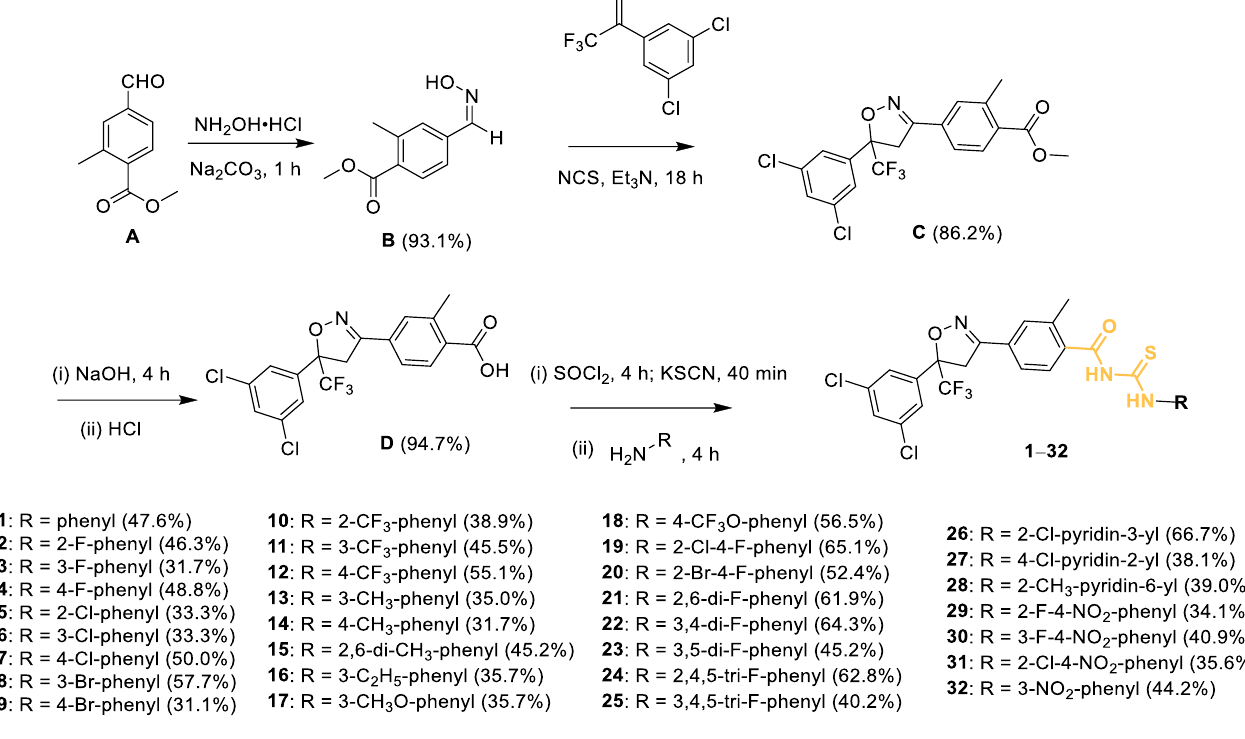
Figure 2. Synthesis route of the target compounds 1 – 32.